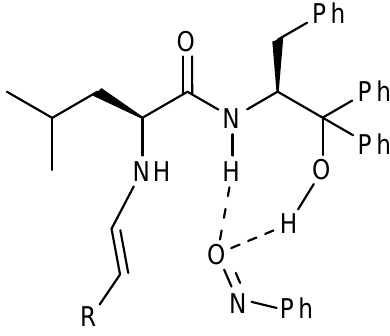
Scheme 36. Reaction process of asymmetric N-specific reaction of nitrosobenzene with